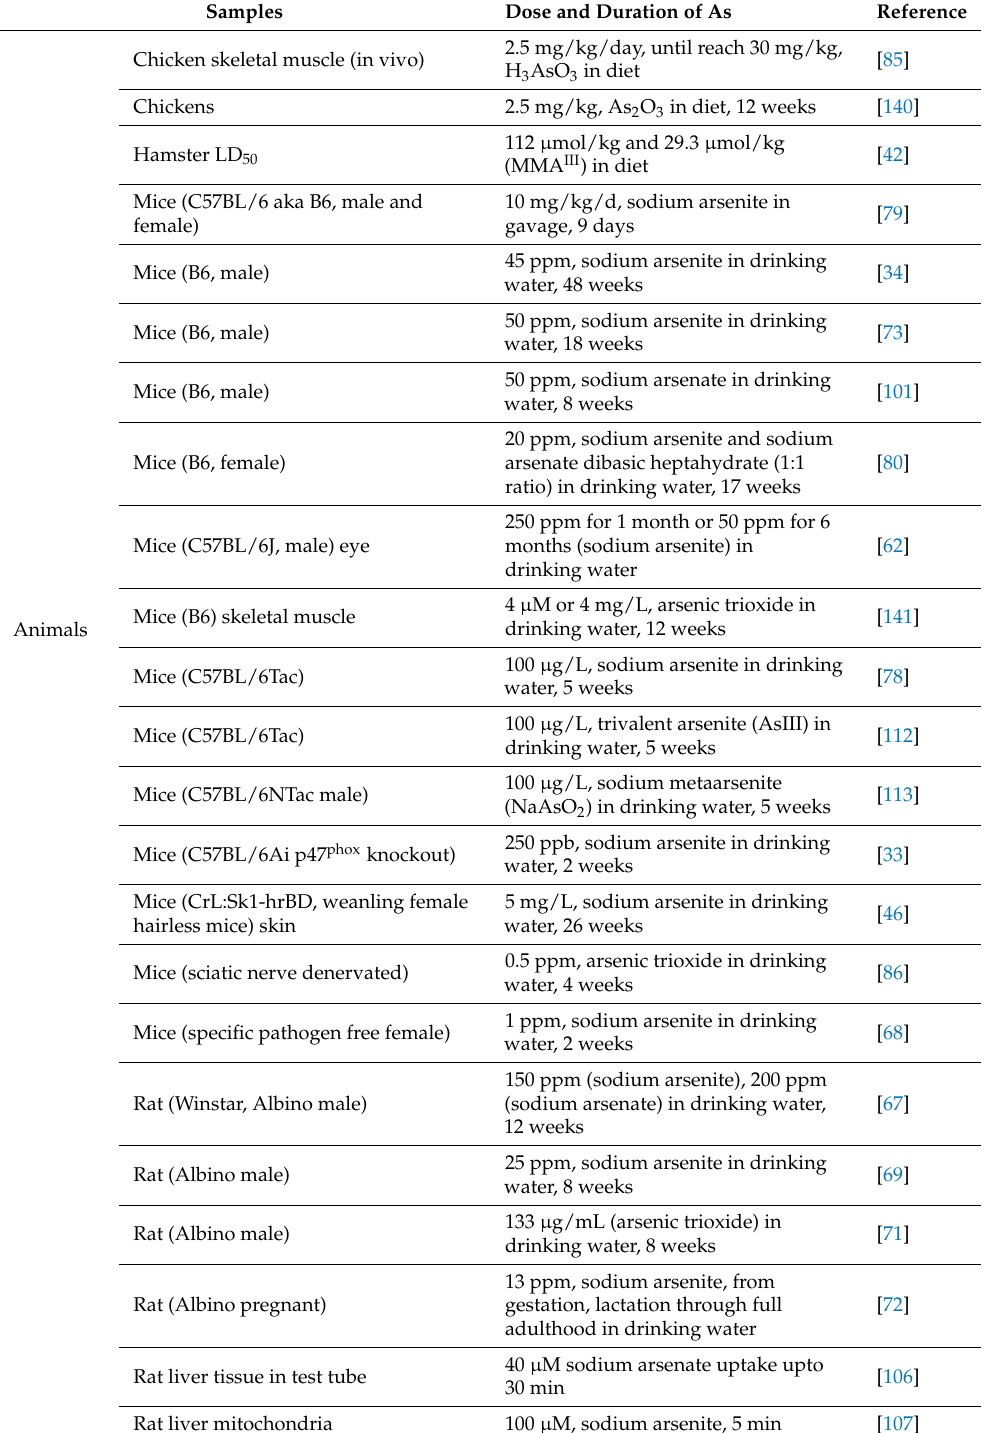
Table 1. Cont. Samples Dose and Duration of As